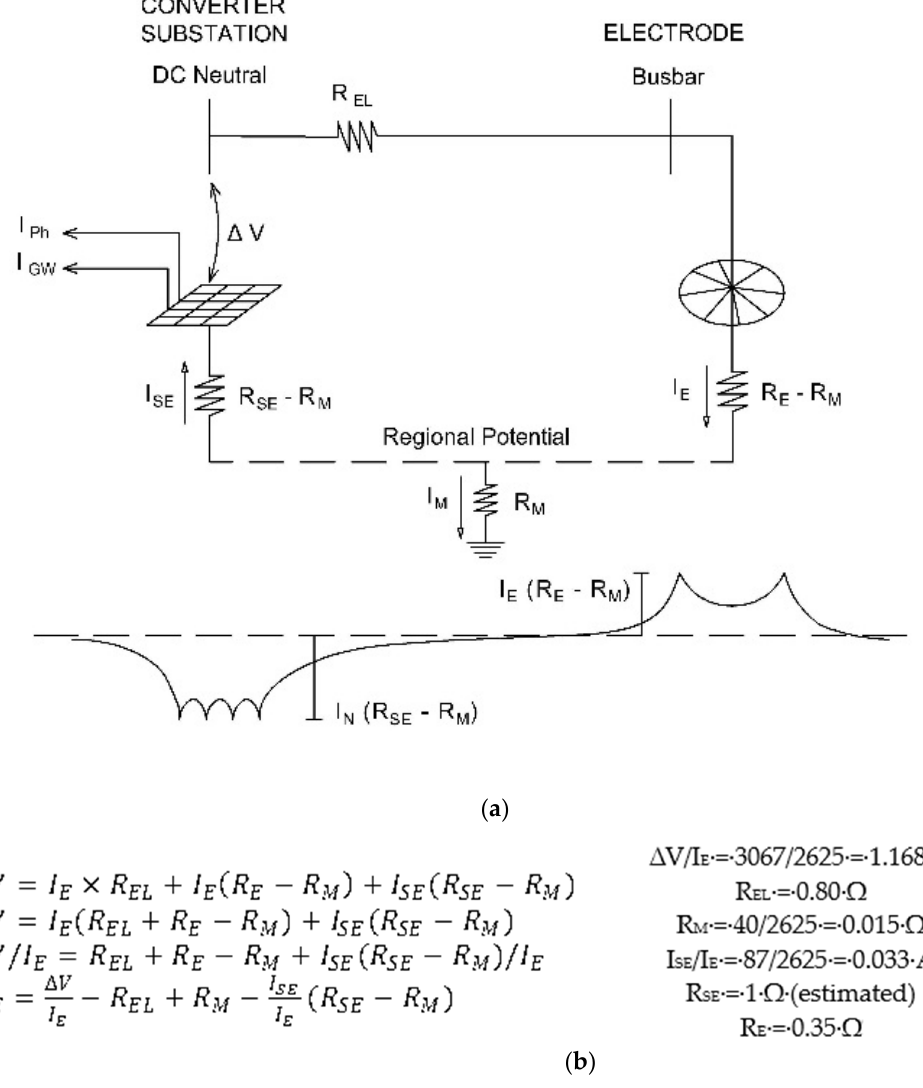
Figure 5. Equivalent circuit of the DC ground loop ( a ) and application of the second Kirchhoff Law (meshes law) for the solution of the circuit ( b ).